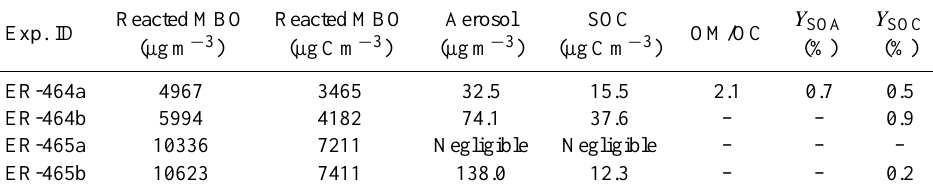
Table 3. OM/OC ratio and SOA and SOC yields. SOA yields could not be calculated for runs involving SO 2 because the filter masses consisted of both SOA and inorganic sulfate, and inorganic sulfate mass concentrations were not independently measured.